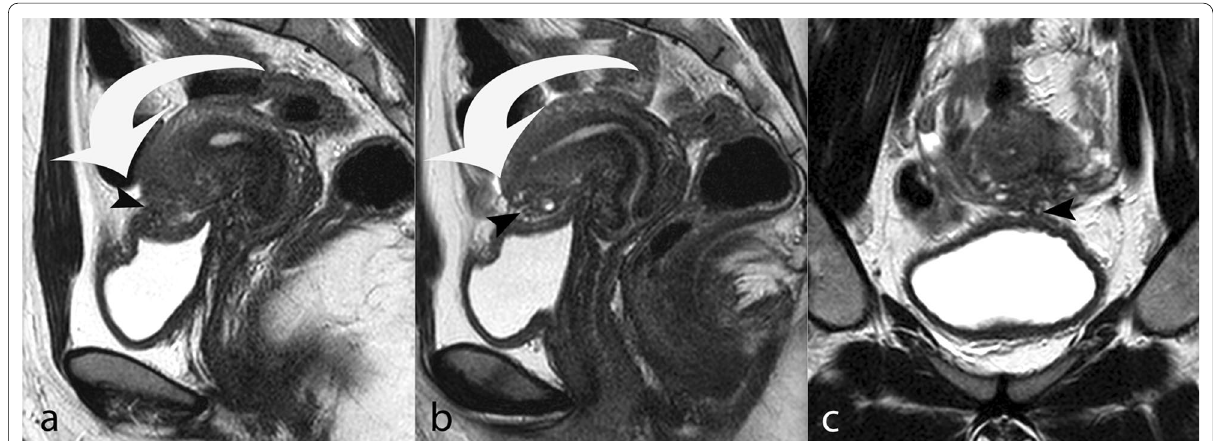
Fig. 10 DIE with vesical infiltration. TSE T2w sagittal ( a , b ) and coronal ( c ) images. The vesico-uterine fold is occupied by a DIE nodule (arrowhead) anteriorly tethering the uterine body (curved arrow)